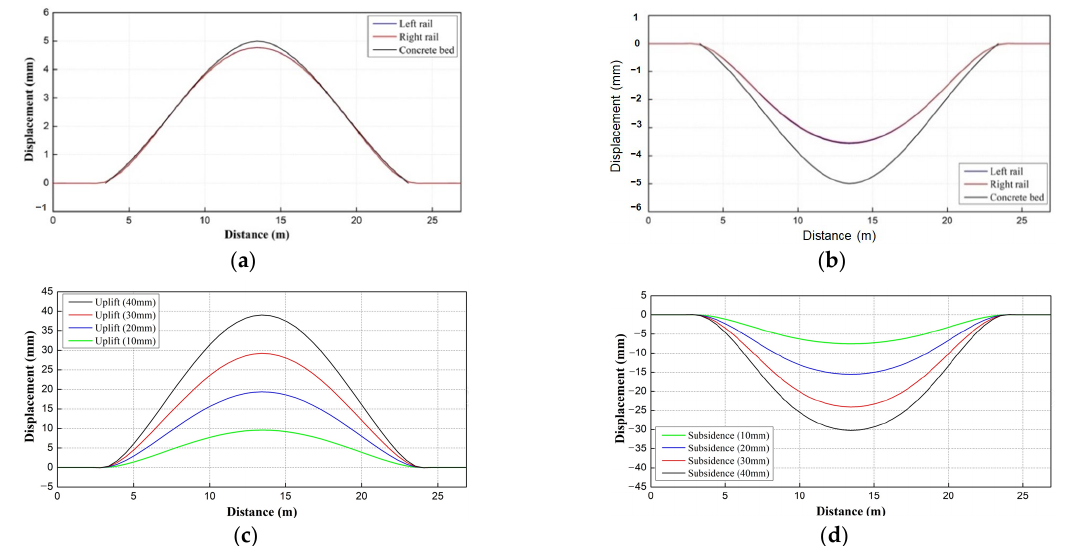
Figure 7. FE analysis results (displacement, z direction) for: ( a ) rails and concrete bed under 5 mm uplift; ( b ) rails and concrete bed under 5 mm subsidence; ( c ) rails under 10–40 mm uplift; and ( d ) rails under 10–40 mm subsidence.